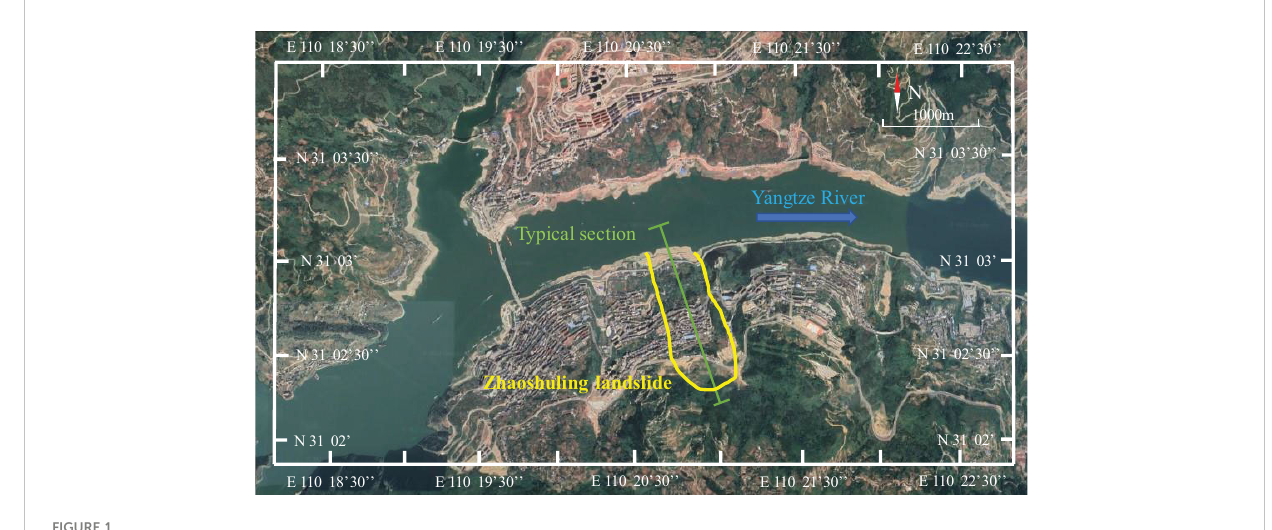
FIGURE 1 Location of the Zhaoshuling